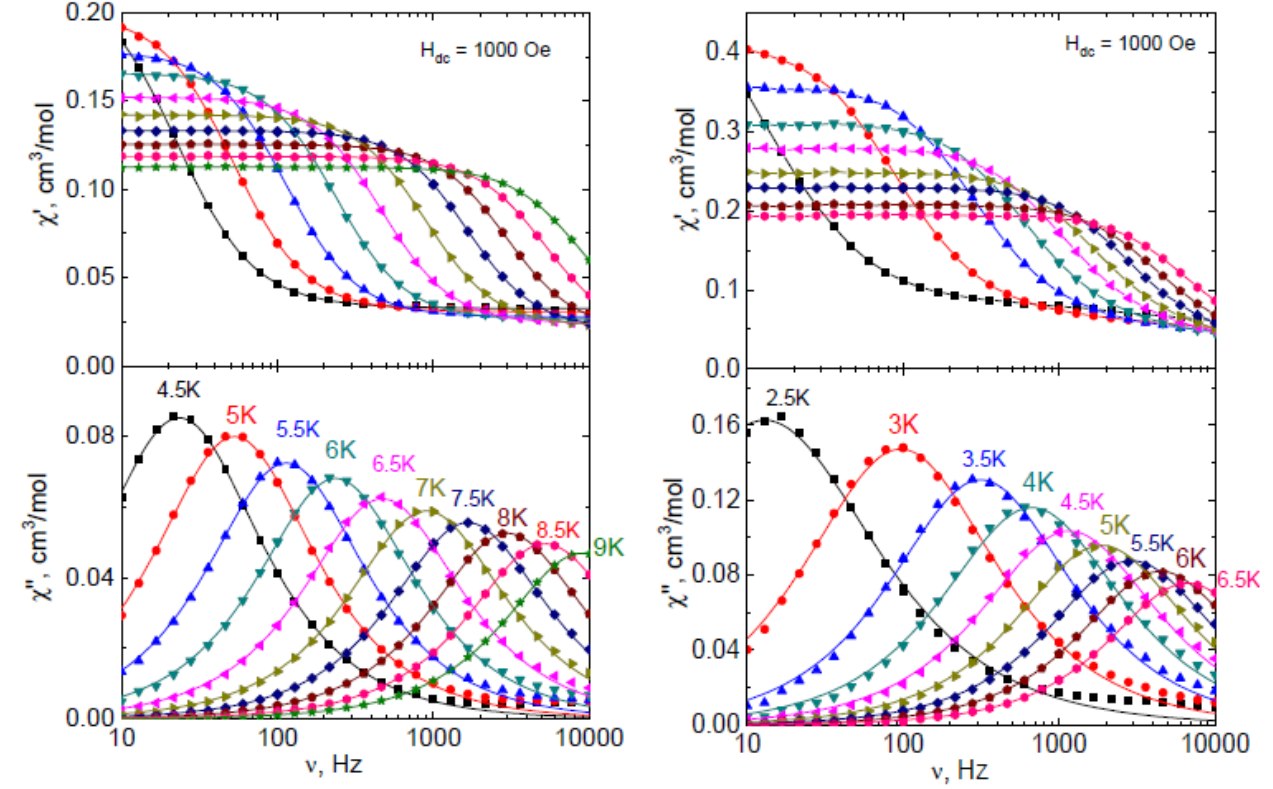
Figure 3. Frequency dependences of the in- phase (χ′ ) and out-of- phase (χ″ ) components of the AC magnetic susceptibility of complexes 1Yb ( left ) and 2Yb ( right ) in a DC magnetic field of optimal intensity.